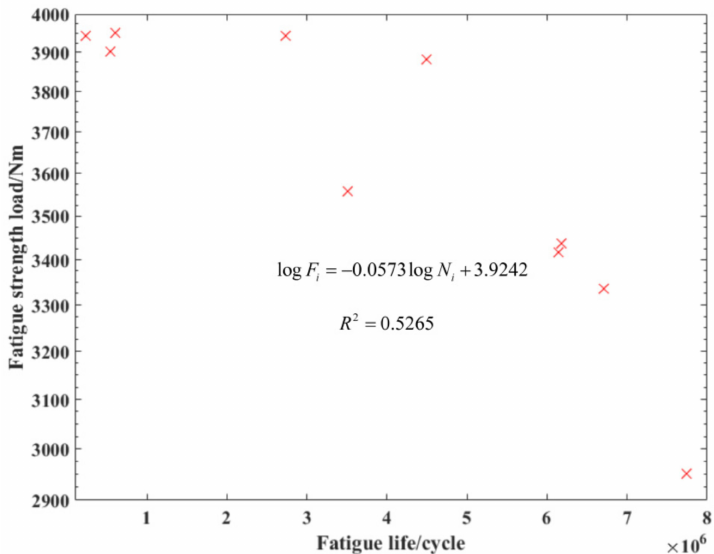
Figure 17. Fatigue test results of the crankshaft.